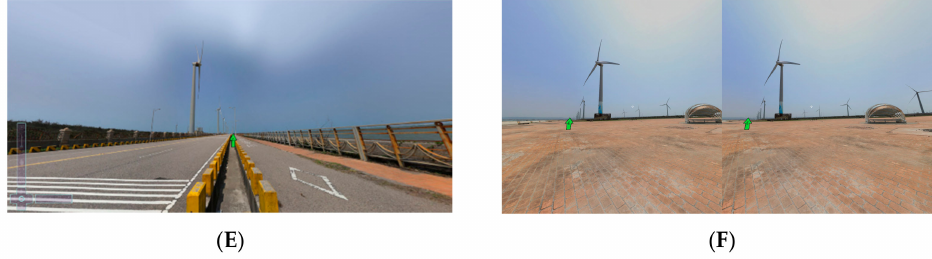
Figure 9. Scenes in the developed virtual tour environment with the connectors for browsing multiple panoramic stations. ( A – F ) indicates Stations A to F, and ( F ) shows the VR mode.